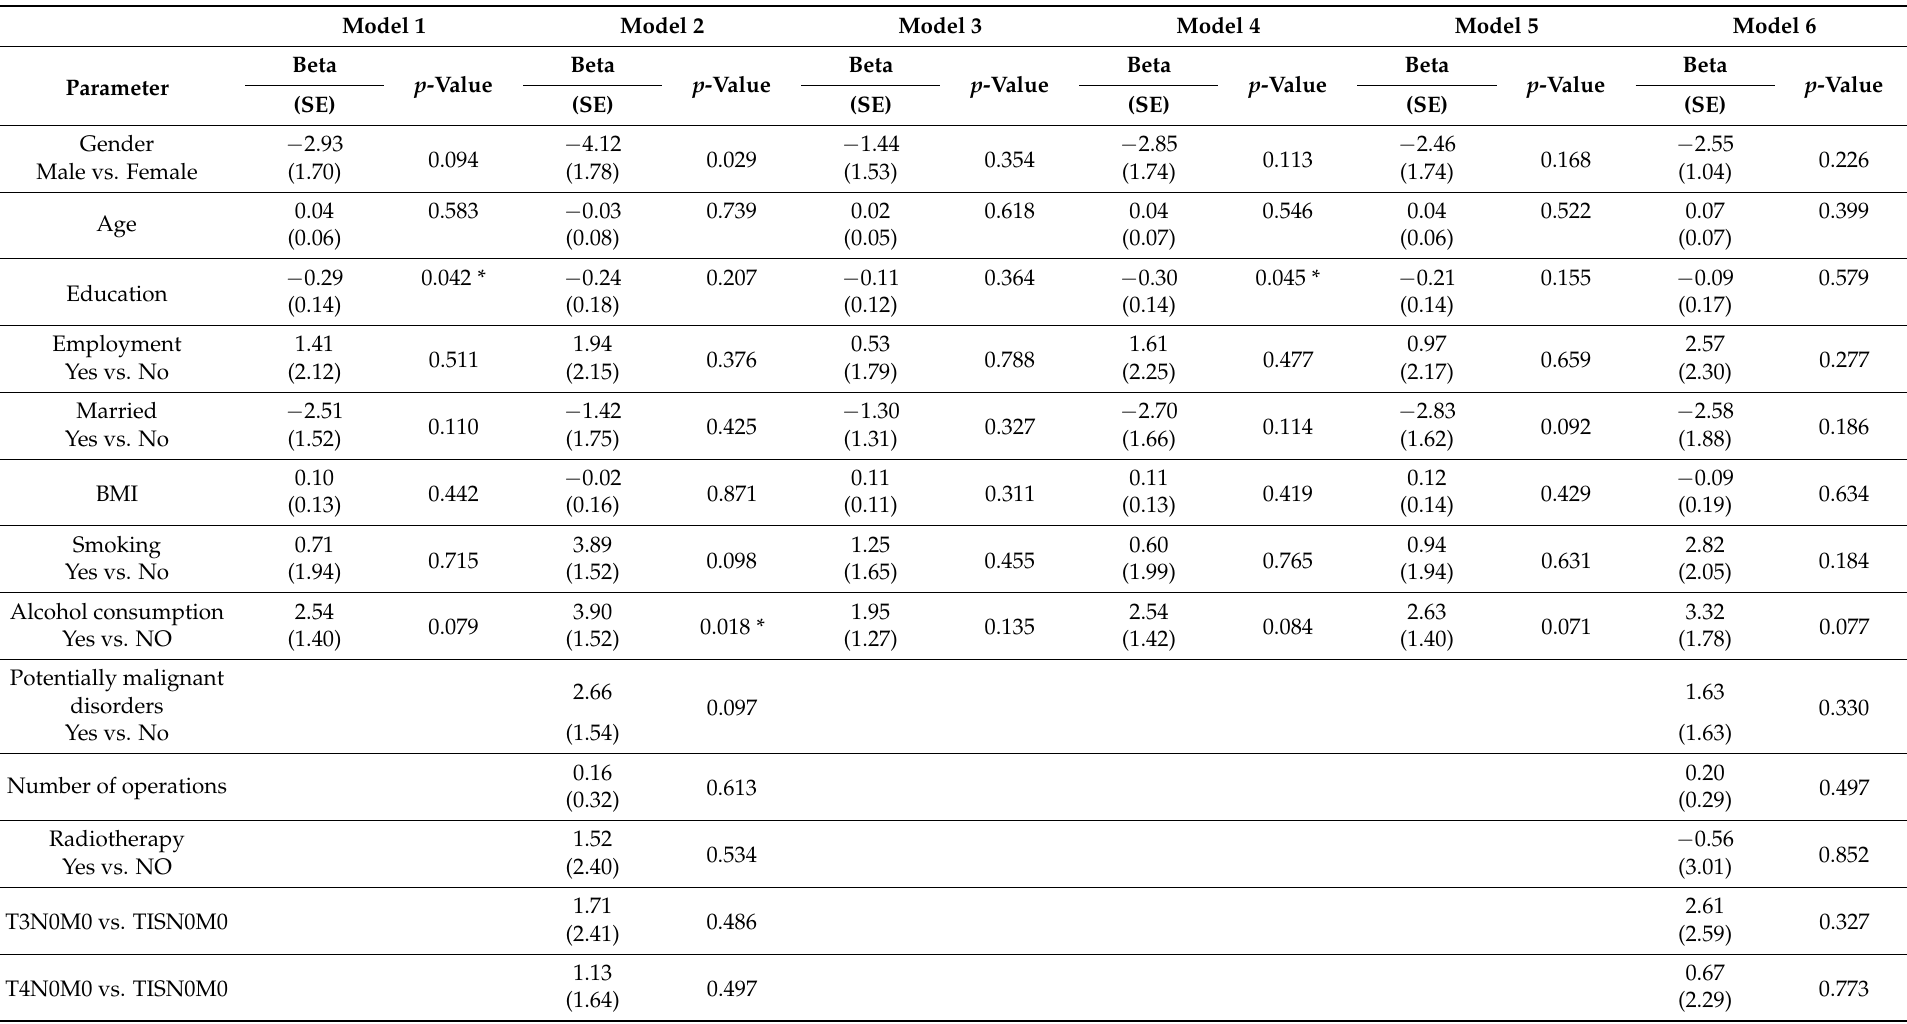
Table 6. Multiple linear regression analysis predicting poor QoS (PSQI > 5) in 50 OC